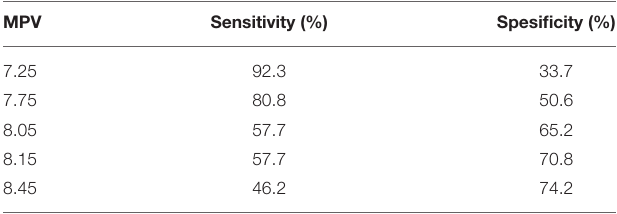
TABLE 4 | Cut-off values of mean platelet volume when D-dimer ≥ 1.0 mg/L for intensive care unit admission state.